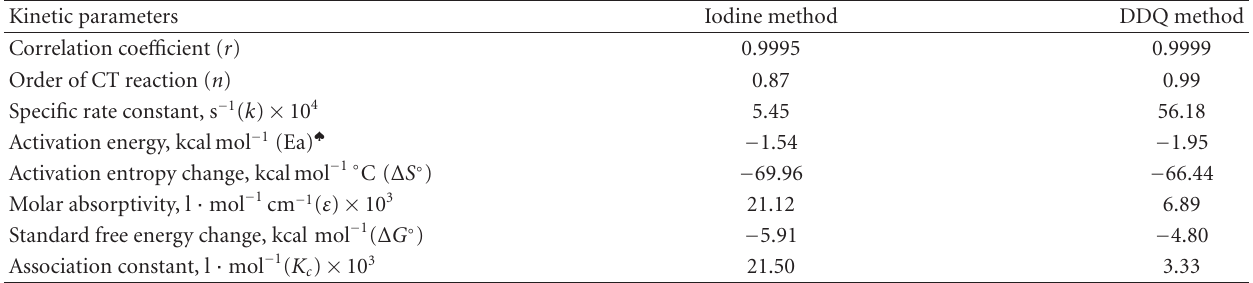
Table 2: Kinetic parameters obtained from Benesi-Hildebrand, Arrhenius, and first-order linear plots of OMZ-acceptor CT complexes at the specific λ max and reaction